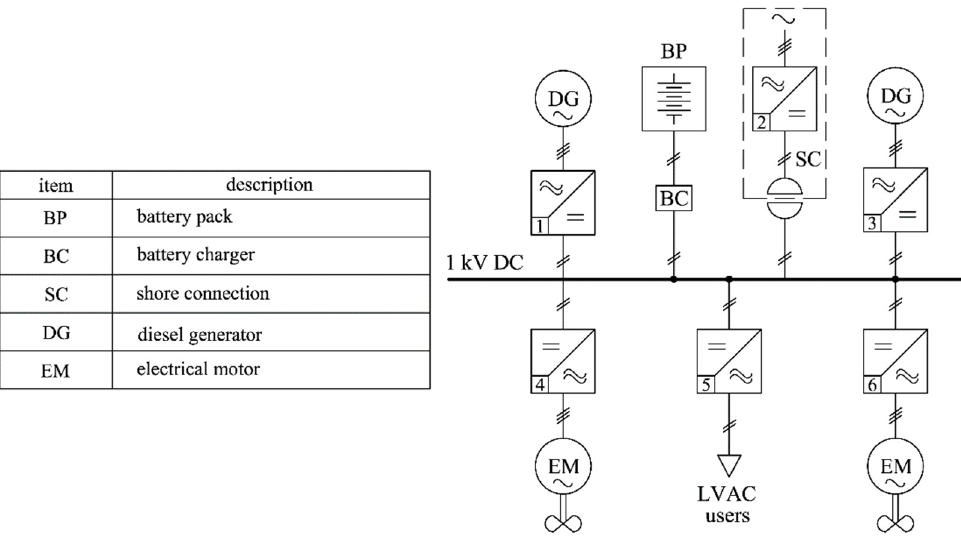
Figure 2. Bidirectional ferry onboard DC power system [19].